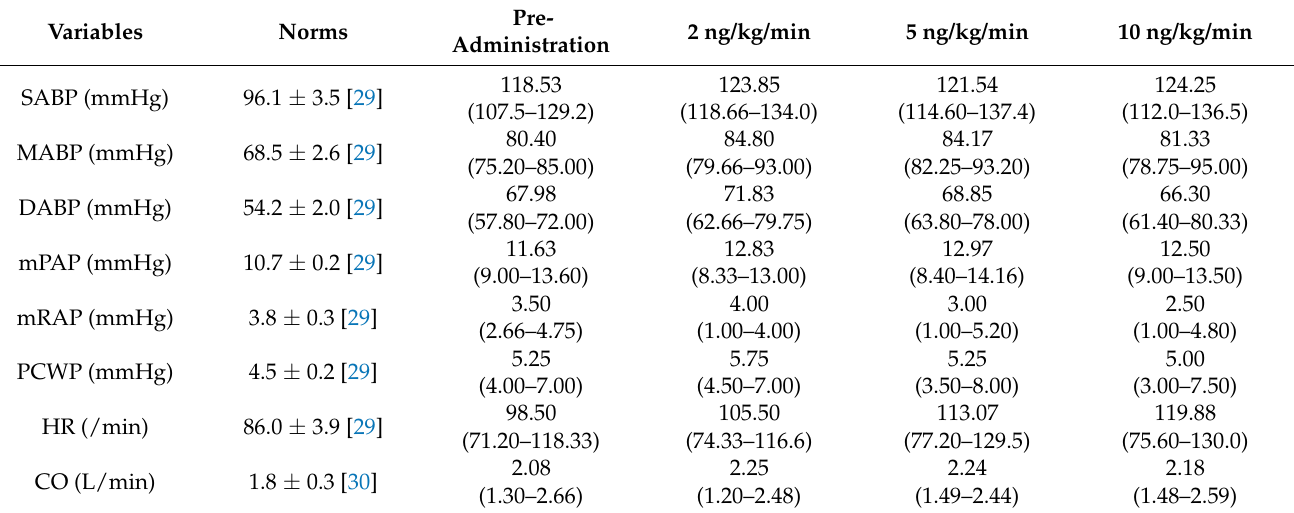
Table 3. Comparison of systemic circulation parameters at each time